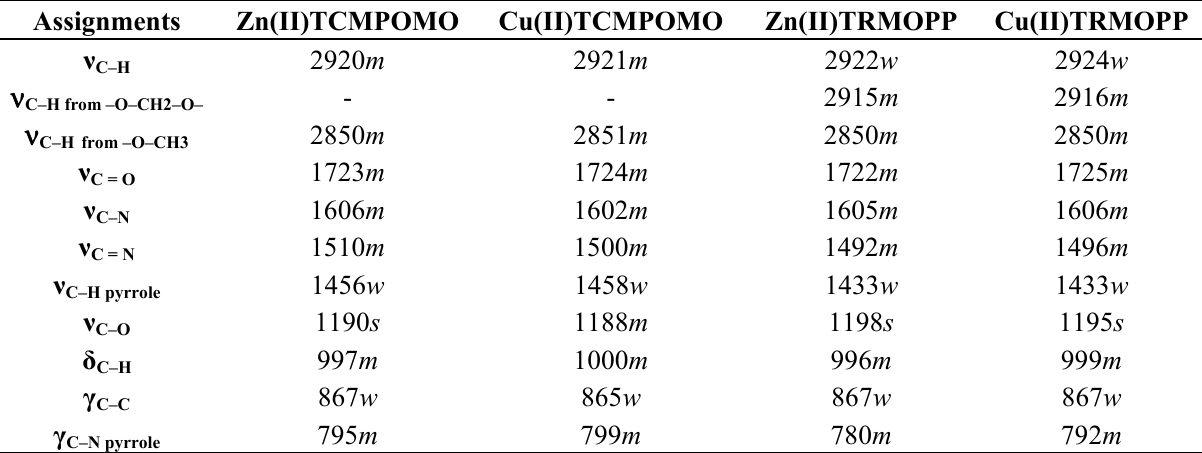
Table 1. Infrared spectral assignments of the unsymmetrical mesoporphyrinic complexes (cm − 1 ).